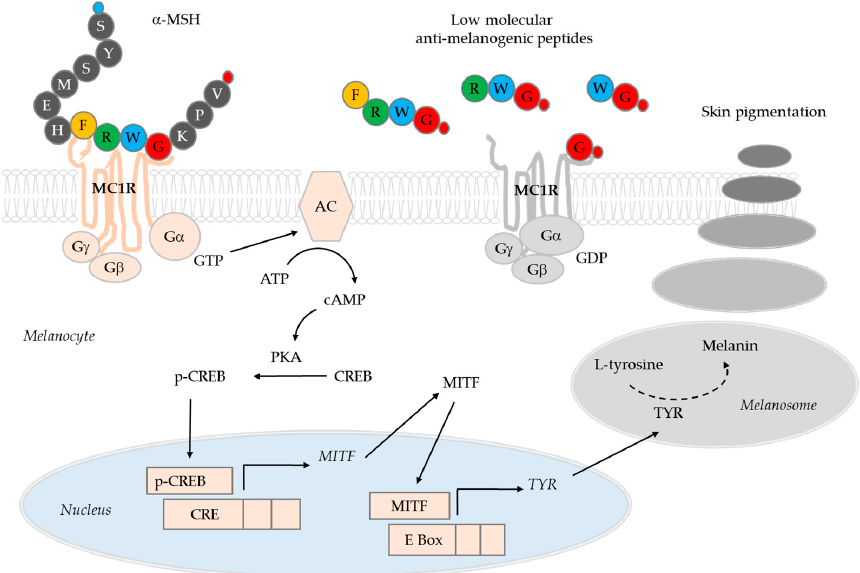
Figure 4. A working hypothesis for the mechanism of action of low molecular anti-melanogenic peptides. α -Melanocyte-stimulating hormone (MSH) binds to the G-protein coupled MC1R receptor to activate adenylate cyclase (AC). The resulting cAMP-dependent activation of protein kinase A (PKA) increases the phosphorylation of cAMP-responsive element-binding protein (CREB), and then p-CREB enters the nucleus to increase the expression of microphthalmia-associated transcription factor (MITF). MITF transcription factors increase melanin synthesis by inducing the expression of tyrosinase (TYR) which catalyzes the key reactions in melanin synthesis in melanosomes. Melanosomes migrate from melanocytes to epidermal keratinocytes, resulting in melanin deposition and skin pigmentation. In a previous study, we identified low molecular anti-melanogenic peptides, such as FRWG-NH 2 , RLWG-NH2, FRWG-NH2, FWG-NH2, LWG-NH2, RWG-NH 2 , WG-NH 2 , and G-NH 2 (glycinamide), some of which share common sequences with α -MSH (acetyl-SYSMEHFRWGKPV-NH 2 ) [27]. In the cartoons of α -MSH and anti-melanogenic peptides, amino acids are represented with single letter symbols in closed circles. The small blue and red circles represent an acetyl group and an amide group, respectively. In the present study, we reported that glycinamide (G-NH 2 ) in its hydrochloride salt form exhibited significant human skin depigmentation efficacy. Further studies are needed in order to examine the depigmentation efficacy of other low molecular anti-melanogenic peptides.